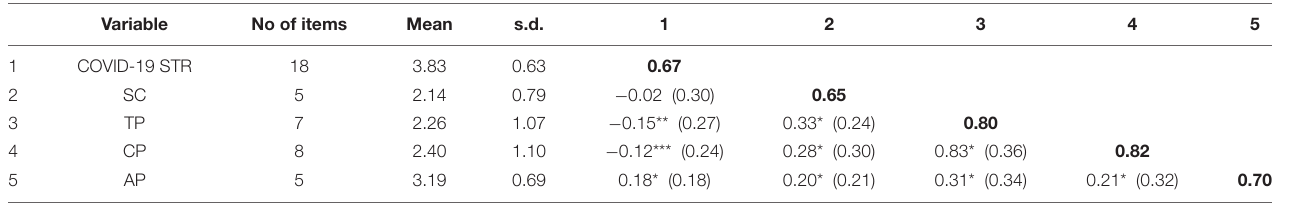
TABLE 3 | Descriptive statistics and correlations.